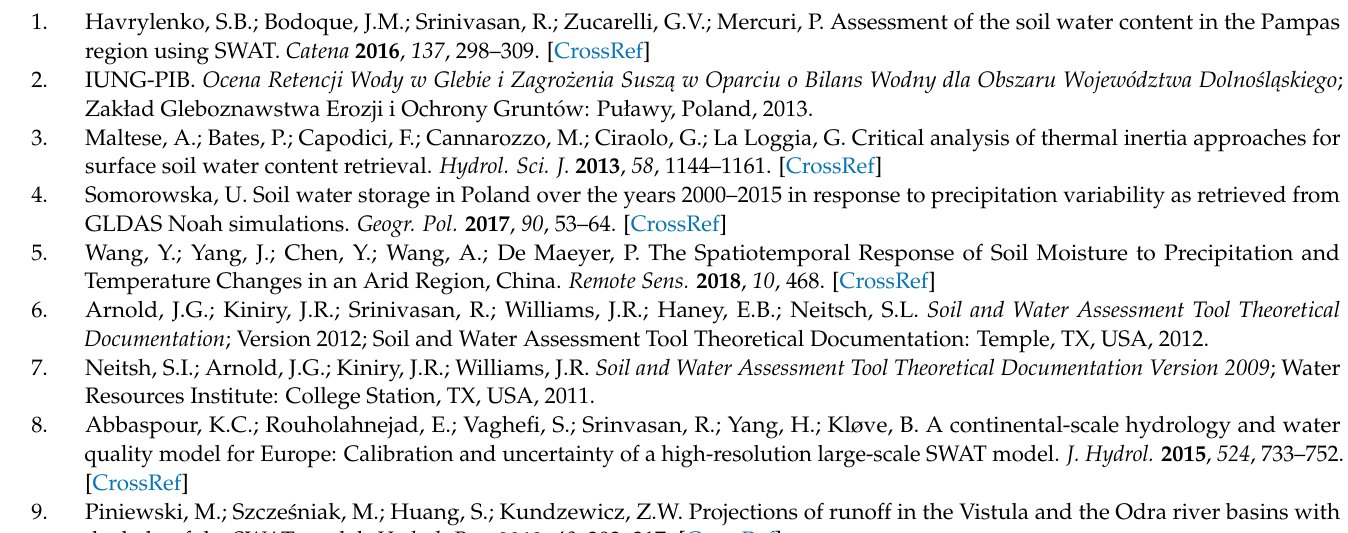
10, 22, 31) by season between Variant 1 (V1-BaU) and Variants 2.1 and 3.1 for the years 2041–2050 in the Bystra catchment for climate scenarios RCP 4.5 and RCP 8.5. Bold numbers indicate actual evapotransspiration (mm) and shaded numbers indicate percentage change. Shade of red indicates % decrease in content and shade of blue indicates % increase in content (author’s own elaboration). Table S14. Comparison of average soil water content in the selected sub-catchment (1, 4, 9, 10, 22, 31) by season between Variant 1 (V1-BaU) and Variants 2.1 and 3.1 for the years 2041–2050 in the Bystra catchment for climate scenarios RCP 4.5 and RCP 8.5. Bold numbers indicate soil water content (mm) and shaded numbers indicate percentage change. Shade of red indicates % decrease in content and shade of blue indicates % increase in content (author’s own elaboration). Table S15. Comparison of mean total runoff in the selected sub-catchment (1, 4, 9, 10, 22, 31) by season between Variant 1 (V1-BaU) and Variants 2.1 and 3.1 for the years 2041–2050 in the Bystra River catchment for climate scenarios RCP 4.5 and RCP 8.5. Bold numbers indicate total runoff (mm) and shaded numbers indicate percentage change. Shade of red indicates % decrease in content and shade of blue indicates % increase in content (author’s own elaboration). Table S16. Comparison of average sediment yield in the selected sub-catchment (1, 4, 9, 10, 22, 31) by season between Variant 1 (V1-BaU) and Variants 2.1 and 3.1 for 2041–2050 in the Bystra catchment for climate scenarios RCP 4.5 and RCP 8.5. Bold numbers indicate sediment yield (t/ha) and shaded numbers indicate percentage change. Shade of red indicates % decrease in content and shade of blue indicates % increase in content (author’s own elaboration). Table S17. Summary of the average: actual evapotranspiration (mm), soil water content (mm), total runoff (mm) and sediment yield (t/ha) for the entire Bystra catchment by season between Variant 1 (V1-BaU) and Variants 2.1 and 3.1 for the years 2041–2050 for climate scenarios RCP 4.5 and RCP 8.5. Bold numbers indicate the corresponding value and shaded numbers indicate the percentage change. Shade of red indicates % decrease in content and shade of blue indicates % increase in content (author’s own